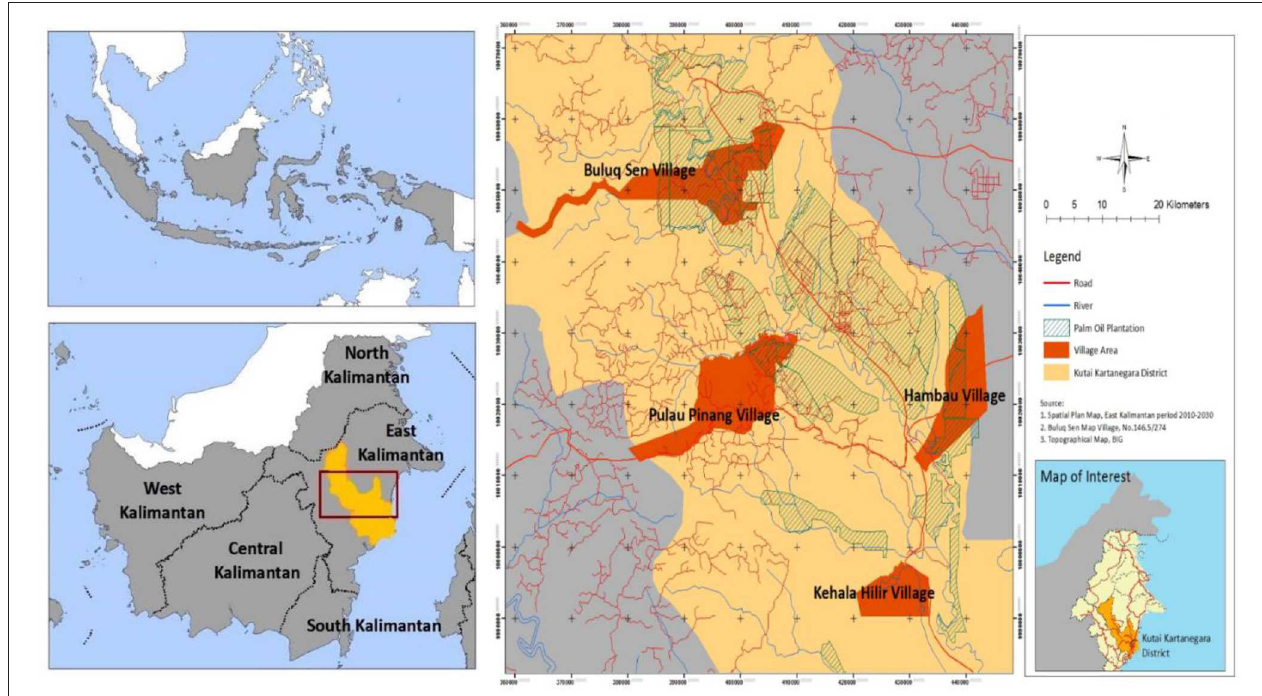
FIGURE 1 | Map of research sites. Copyright